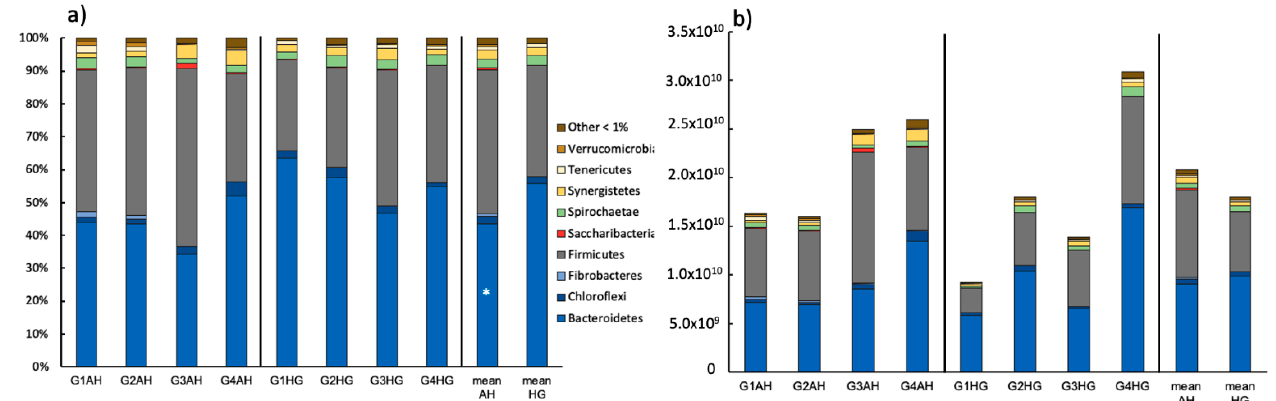
Figure 1. ( a ) Relative ruminal bacterial community composition of goats fed an AH diet (left) or HG diet (middle) and mean values of both treatments (right), respectively (phylum-level). Results are based on amplicon sequencing of the V4 region of the 16S rRNA gene and phyla ≥ 1% abundances are depicted; ( b ) Absolute bacterial community composition based on relative abundance and total bacterial number as retrieved via qPCR. Significant changes between treatments are indicated by an asterisk.